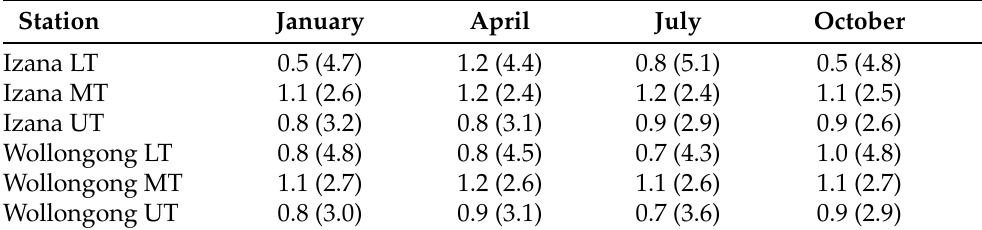
Table 2. Characterization of IASI N 2 O retrieved columns: Degrees of Freedom for Signal (DFS) and retrieval errors (between brackets). LT stands for Lower Troposphere (Surf.–700 hPa), MT for Middle